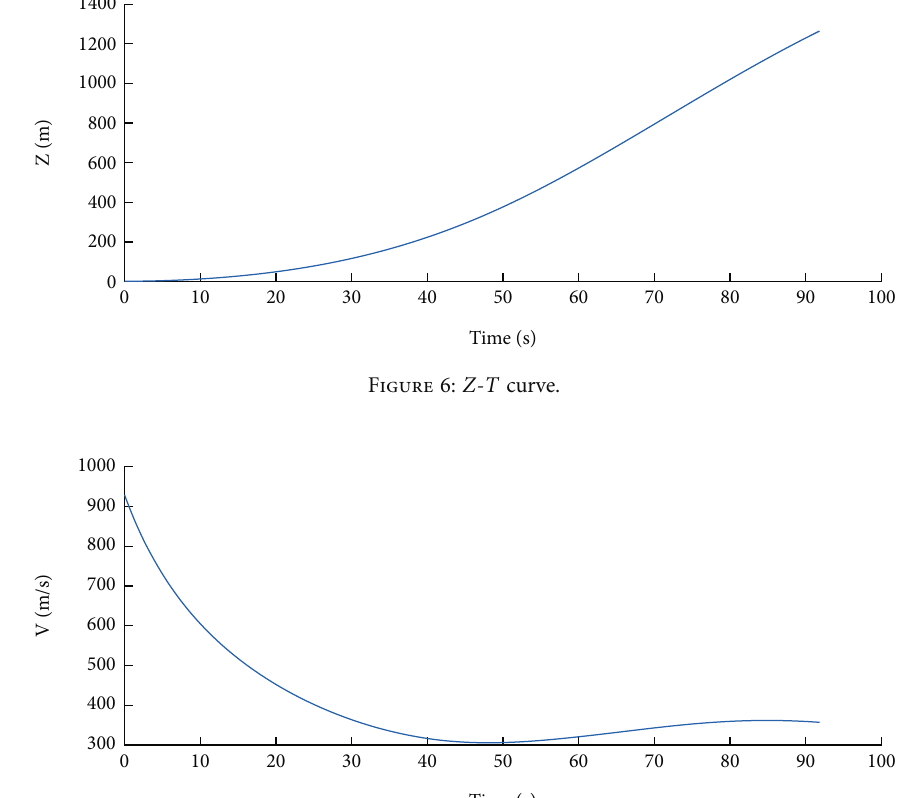
Figure 7: V ‐ T curve.